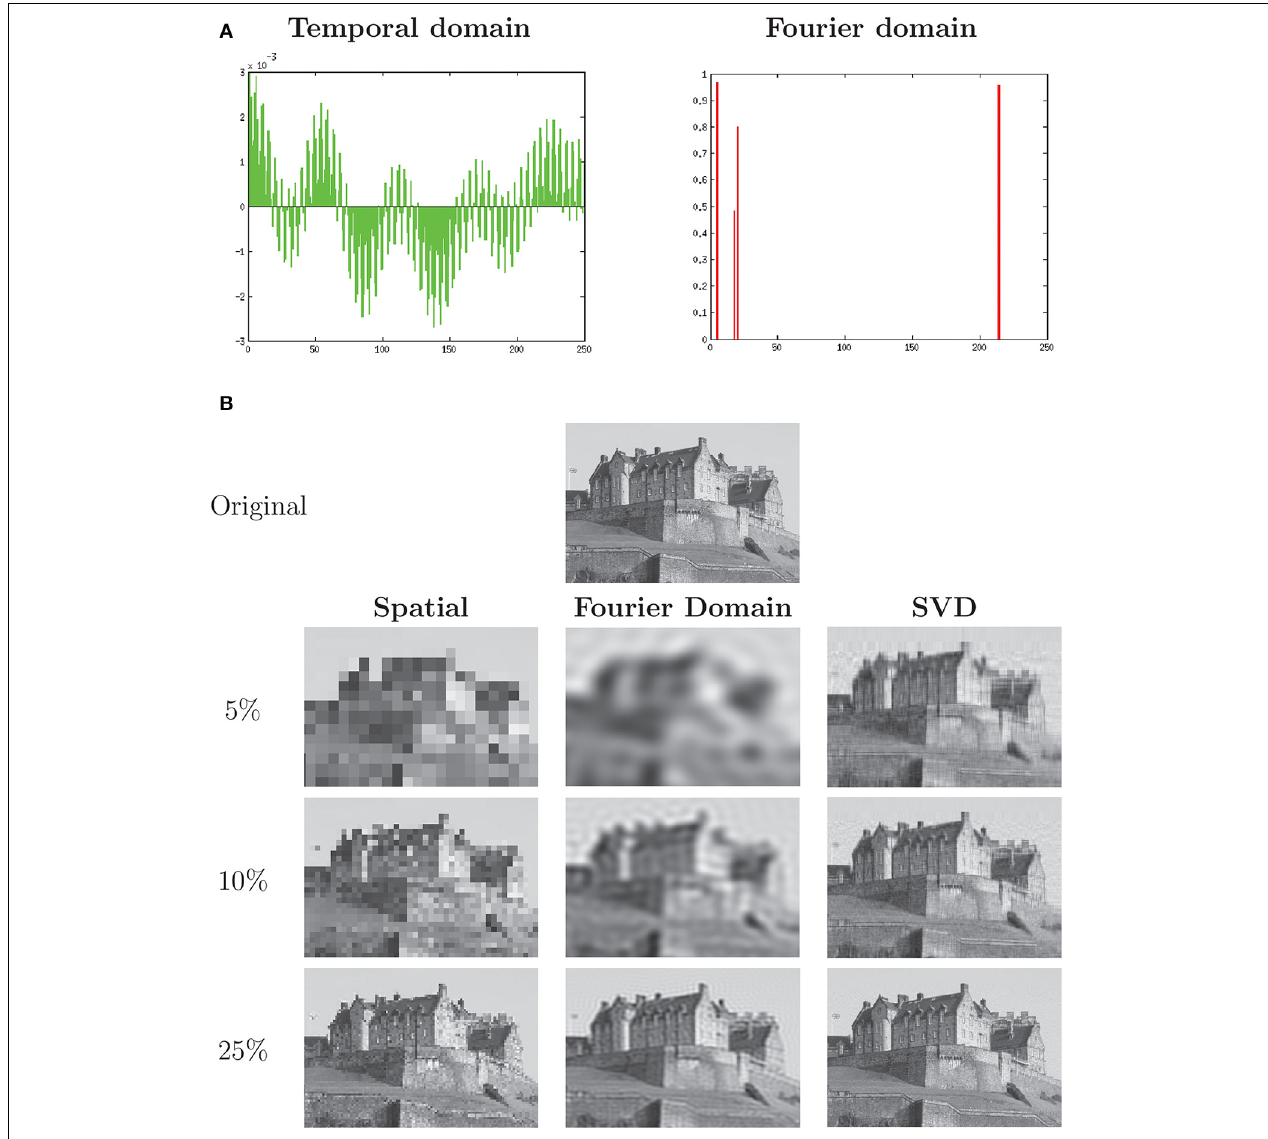
FIGURE 1 | (A) A dense periodic discrete signal may have a sparse representation when transformed into the Fourier domain (DCT-II transform). (B) Image of Edinburgh Castle, with Spatial (Cartesian basis), Discrete Cosine Transform (frequency domain basis) and